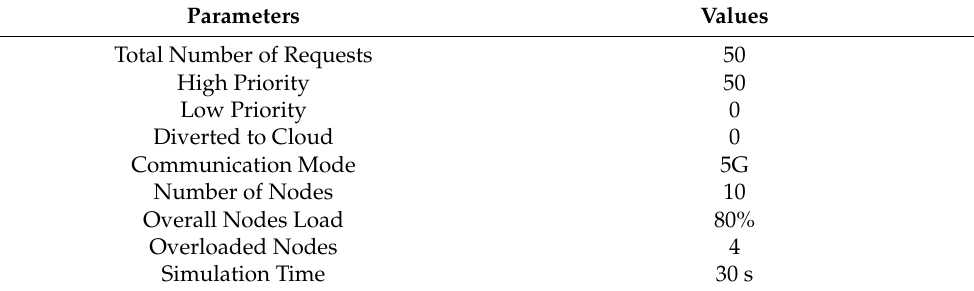
Table 1. Fog scenario 1.